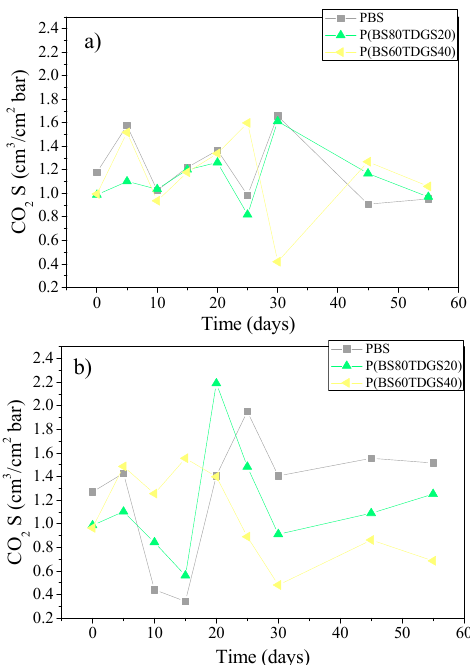
Figure 3. S coefficients for PBS and P(BSxTDGSy) copolymers after: ( a ) thermal aging (at 40 °C, 50% RH, air ventilated); ( b ) photoaging at 23 °C, D65 Neon light, 50% RH, air ventilated.